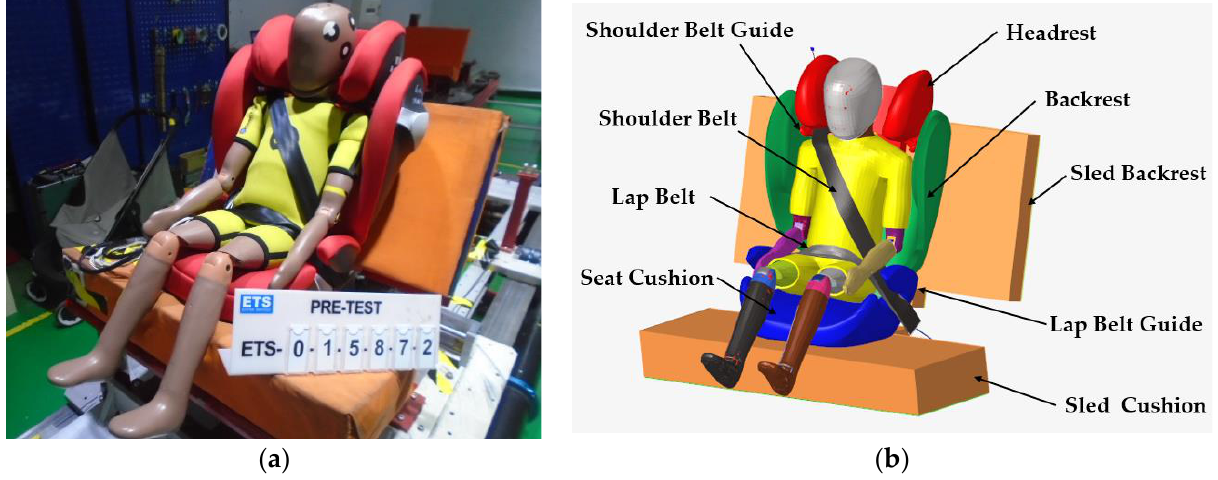
Figure 1. ( a ) Frontal sled test setup; ( b ) The corresponding frontal collision simulation model.